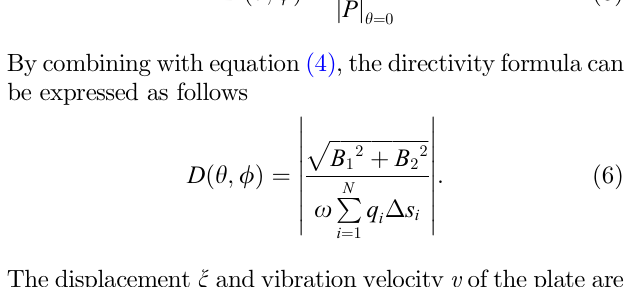
Figure 5. Calculation of the radiation pressure generated by the square-plate